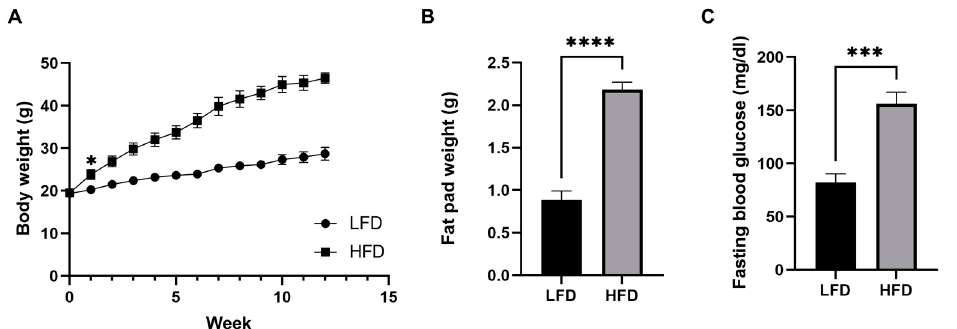
Figure 1. Diet-induced phenotypic variations in male mice. ( A ) Body weight over time. ( B ) Fat pad weight after 12 weeks of diet ( n = 6/group, mean ± SEM). ( C ) Fasting blood glucose after 12 weeks of diet. Student’s t -test * p < 0.05, *** p < 0.001, **** p < 0.0001. Data shown as mean ± SEM. n = 6 LFD, n = 6 HFD.